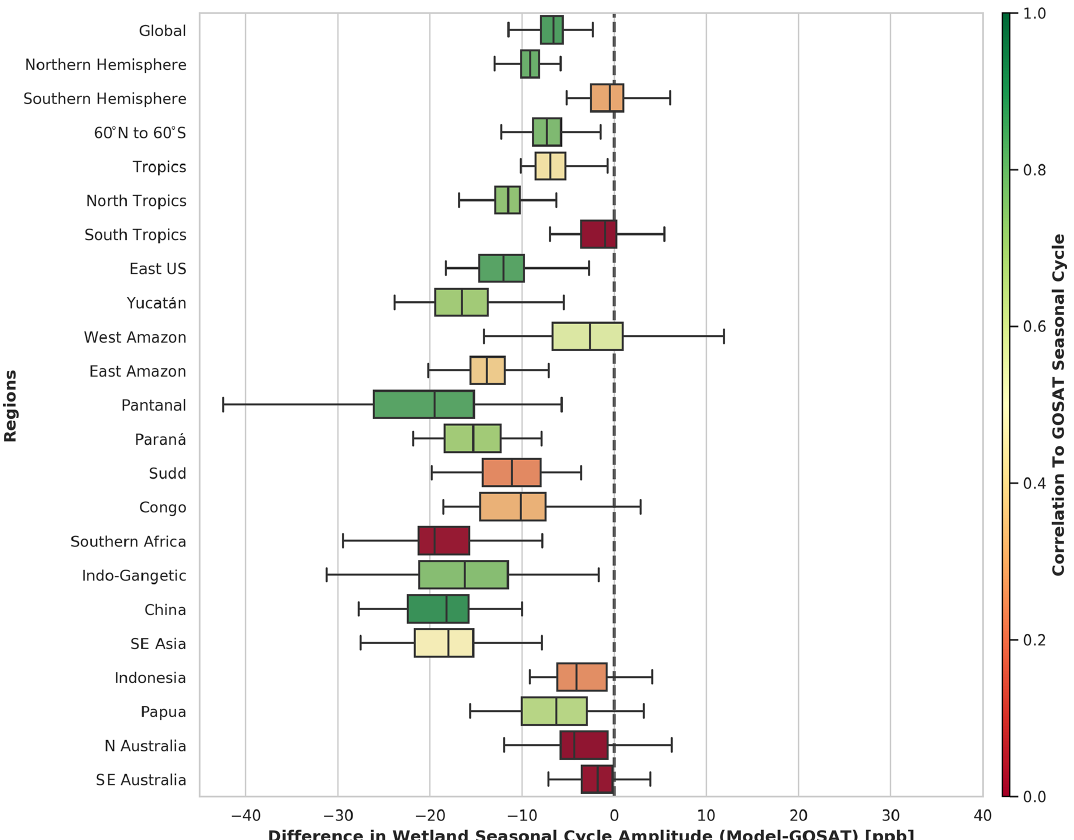
Figure 5. Box plot showing the distribution of the difference in the wetland CH 4 seasonal cycle amplitude between the JULES ensemble and GOSAT observations for all years (2009–2017). A box-and-whisker (box: quartiles; whiskers: min/max) plot is calculated for each of the regions (7 large-scale areas and 16 specific wetland areas) and is coloured by the mean value of the correlation coefficient between the modelled and observed wetland CH 4 seasonal